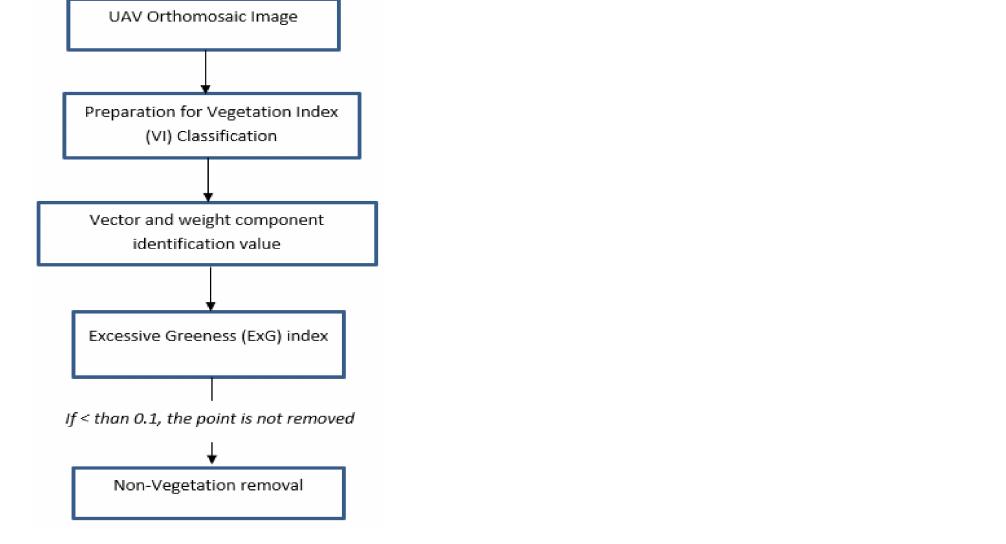
Figure 2. The segregation workflow of vegetation and non-vegetation using VVI and ExG